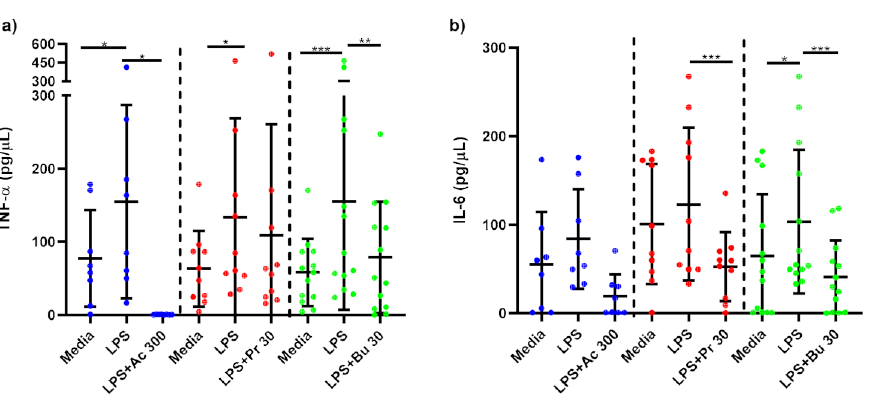
Figure 5. Cytokine response of LPS-stimulated adipose tissue macrophages following short-chain fatty acid treatments. Cell culture supernatant concentrations of ( a ) TNF- α (pg/ µ L); ( b ) IL-6 produced by macrophages stimulated with LPS (1 ng/mL) alone or treated simultaneously with sodium acetate ( n = 10) 300 mM or sodium propionate ( n = 11) 30 mM or sodium butyrate ( n = 13) 30 mM following 15 h incubation. Parametric data analysed by RM one-way ANOVA and post hoc analysis Tukey’s multiple comparison test, non-parametric by the Friedman test and post hoc analysis by Dunn’s mul- tiple comparisons test. TNF- α ; tumour necrosis factor- α , IL-6: interleukin 6, LPS; lipopolysaccharide, Ac; acetate, Pr; propionate, Bu; butyrate. * p < 0.05, ** p < 0.01 and *** p < 0.001. Data expressed as the mean